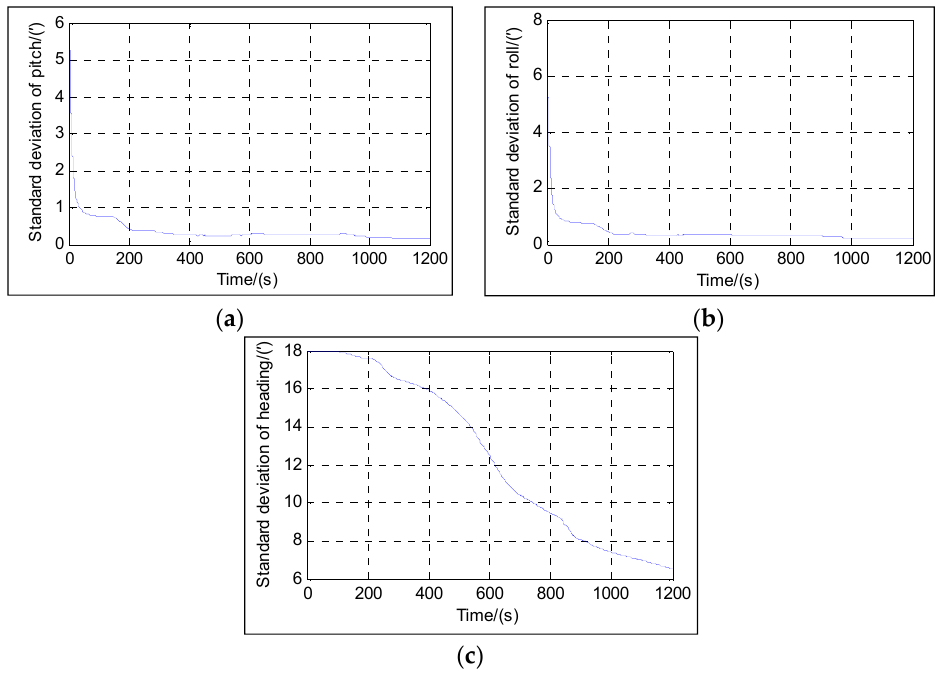
Figure 8. Attitude standard deviation of the direct approach: ( a ) Standard deviation of pitch; ( b ) Standard deviation of roll; ( c ) Standard deviation of heading.